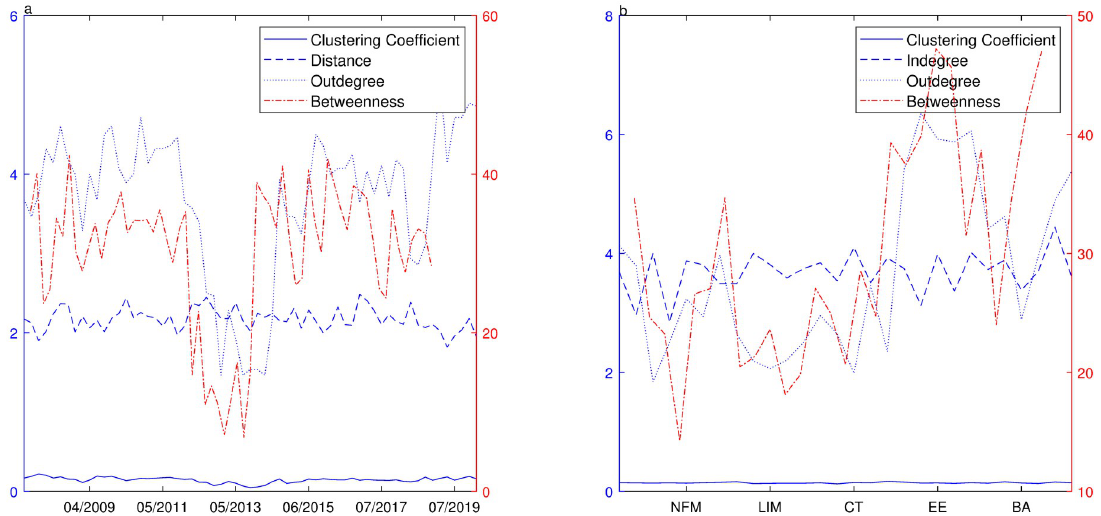
Fig 4. Network topology of industry index over rolling windows. a Shows distributions of the clustering coefficient(solid curve), the distance(dashed curve), the outdegree(dotted curve) and the betweenness(dash-dot curve) over different periods where the clustering coefficient, distance and outdegree are referred to the left Y-axis and average betweenness is referred to the right Y-axis. b Shows distributions of clustering coefficient(solid curve), indegree(dashed curve), outdegree(dotted curve) and betweenness(dash-dot curve) for each industry sector during the whole period where the clustering coefficient, the indegree and the outdegree are referred to the left Y- axis and the betweenness is referred to the right Y-axis.